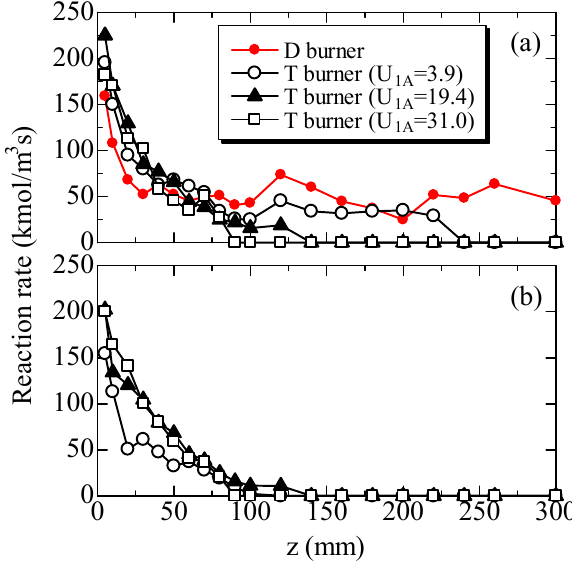
Figure 11. Axial profiles of simulated maximum reaction rate of ( a ) outer flame and ( b ) inner flame in triple port burner are shown. For comparison, profile in double port burner is